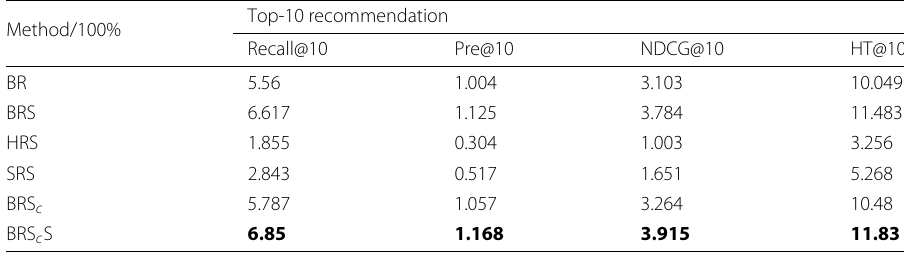
Table 3 Experiment I of top-10